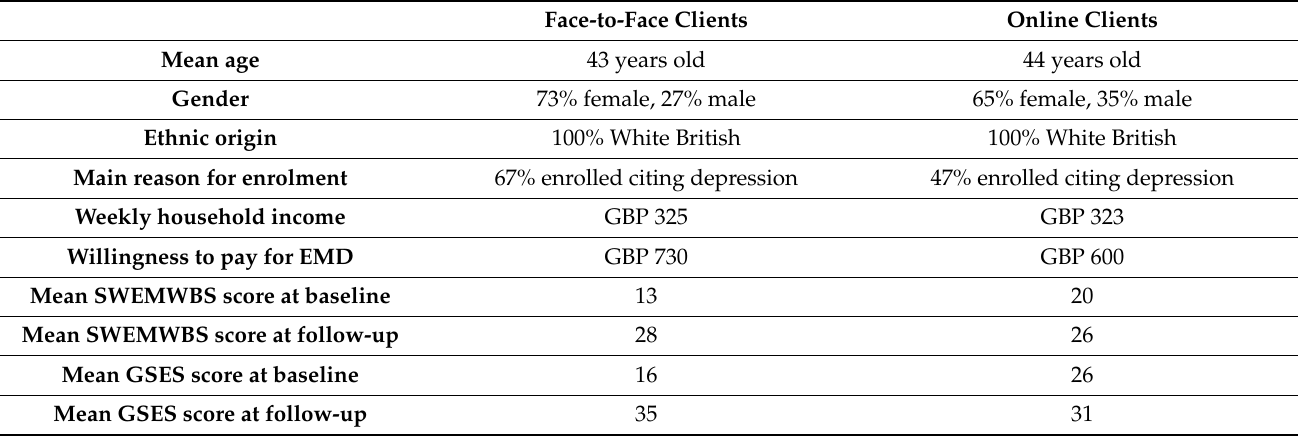
Table 2. Overview of EMD clients.